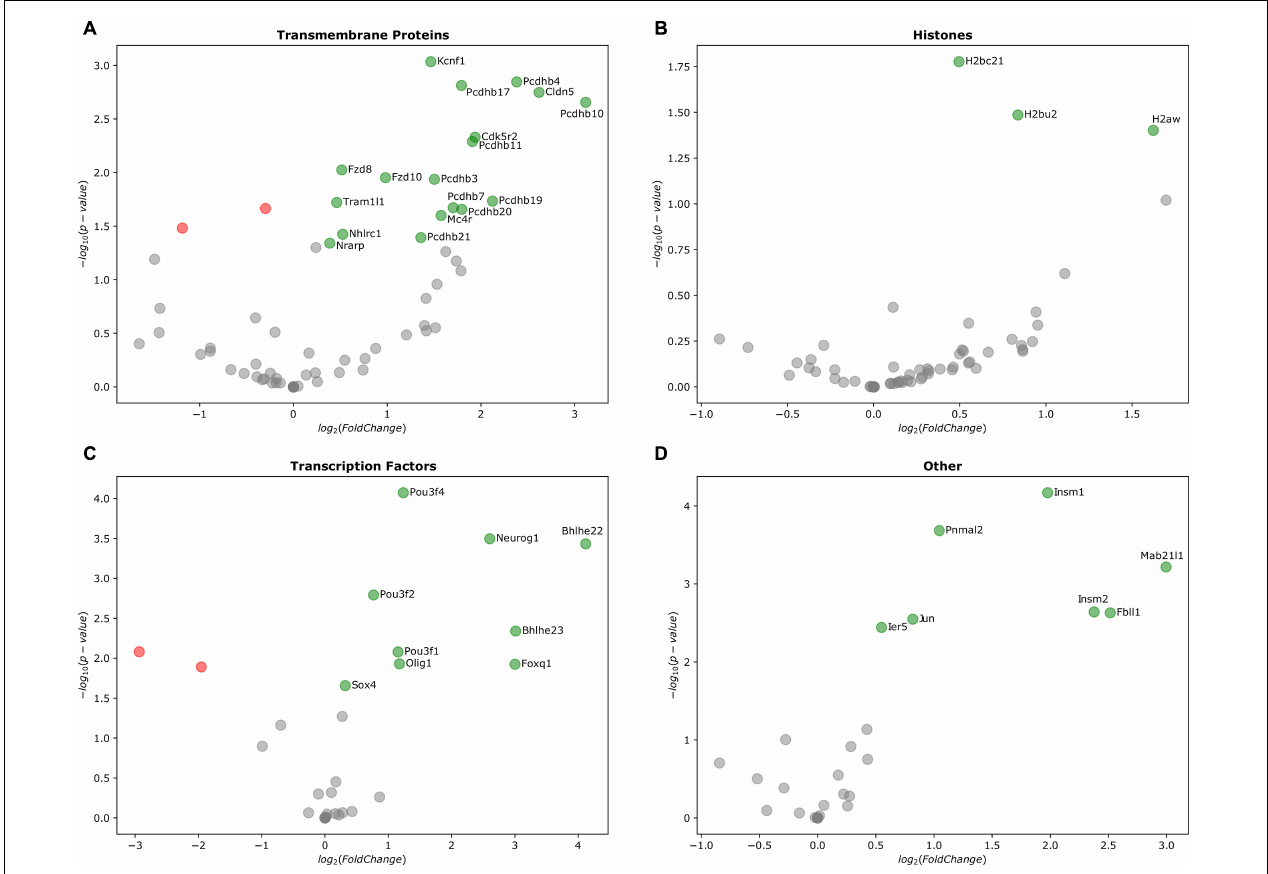
FIGURE 6 | Differentially expressed IGs in the mouse embryonic telencephalon. Expression of genes grouped by their Pfam assignment, determined by their log2-fold change values. Up-regulated genes are highlighted in green, while downregulated genes are colored in red. (A) Gene expression of transmembrane proteins, (B) histones, (C) transcription factors, and (D) other protein